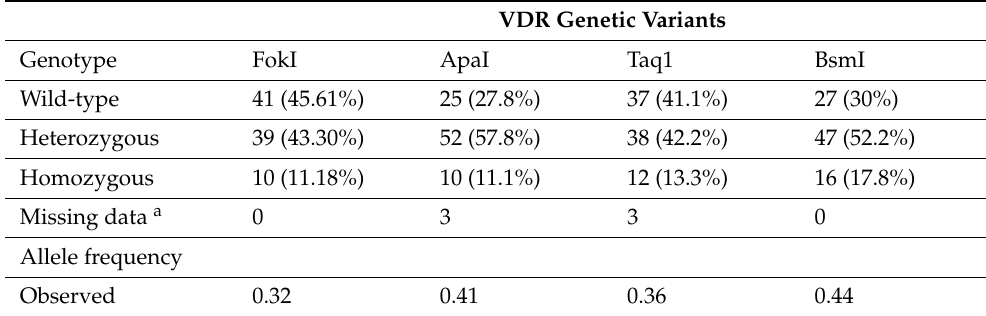
Table 3. Frequencies of VDR FoxI , ApaI , Taq1 , and BsmI genotypes among T2DM patients.